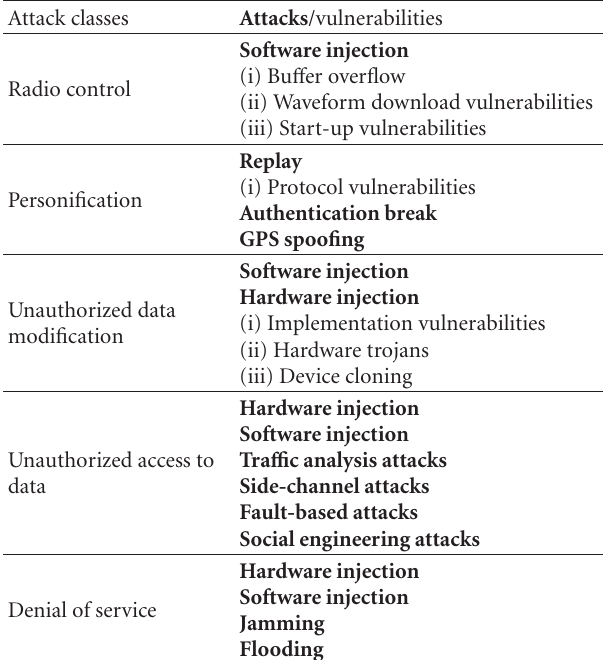
Table 1: Attack classes, associated attacks (in bold) and vulnerabil- ities.